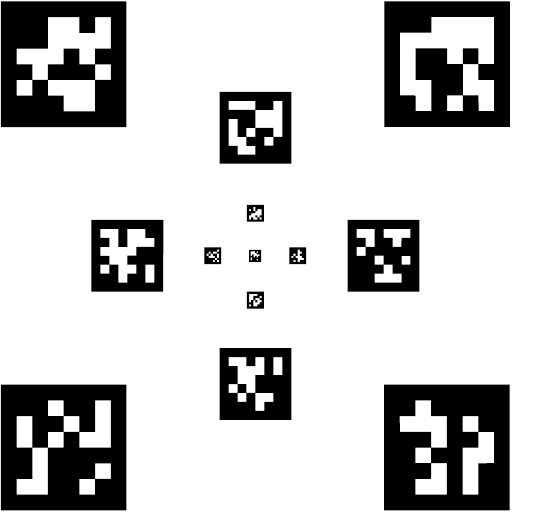
Figure 2. The set S l of AprilTags of different sizes as printed on the landing platform. The list of the detectable tags is represented by the set S l = { 1, . . . , 13 } . At each iteration of the vision system, the detected tags ID are stored in a subset S d ⊆ S l . For T that each detected tag ID i ∈ S d , the vision system computes a transformation matrix c i describes the position in the scene of the identified tag i with respect to the camera frame c . In order to compute the pose of the platform center with respect to the camera for T — i ∈ S l describing the position of each tag i ∈ S l , a set of transformation matrices i p each tag with respect to the platform center—is calibrated and computed offline. Thus,